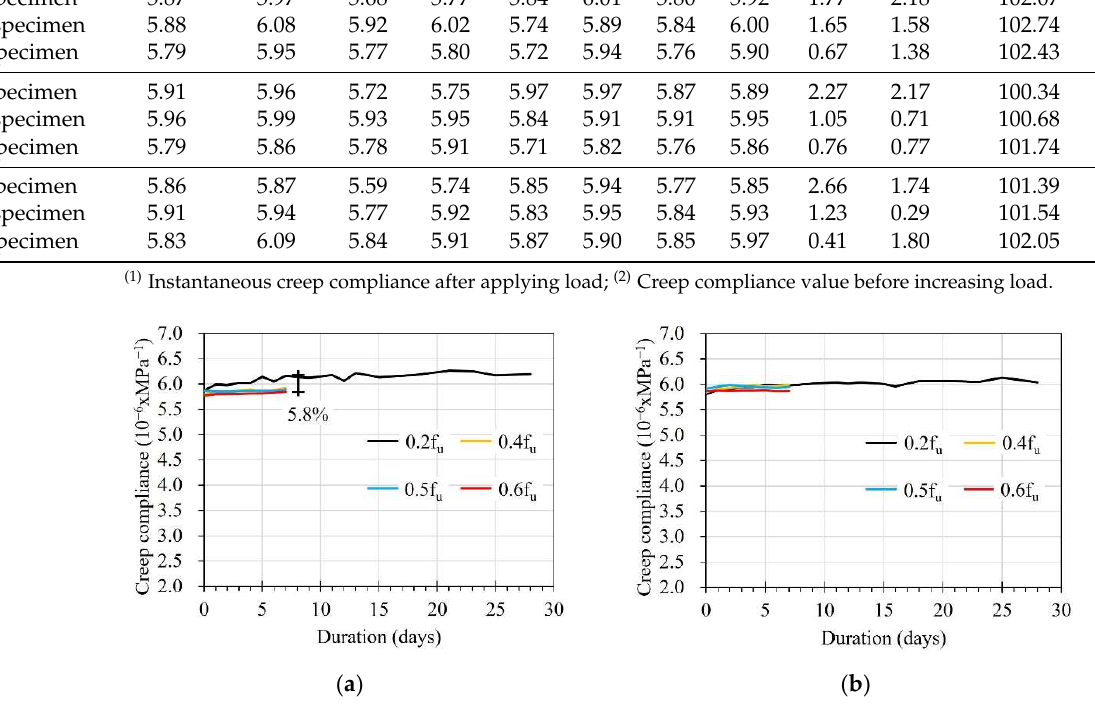
Figure 12. Creep compliance of the FRP strip: ( a ) The E specimen; ( b ) The C specimen.